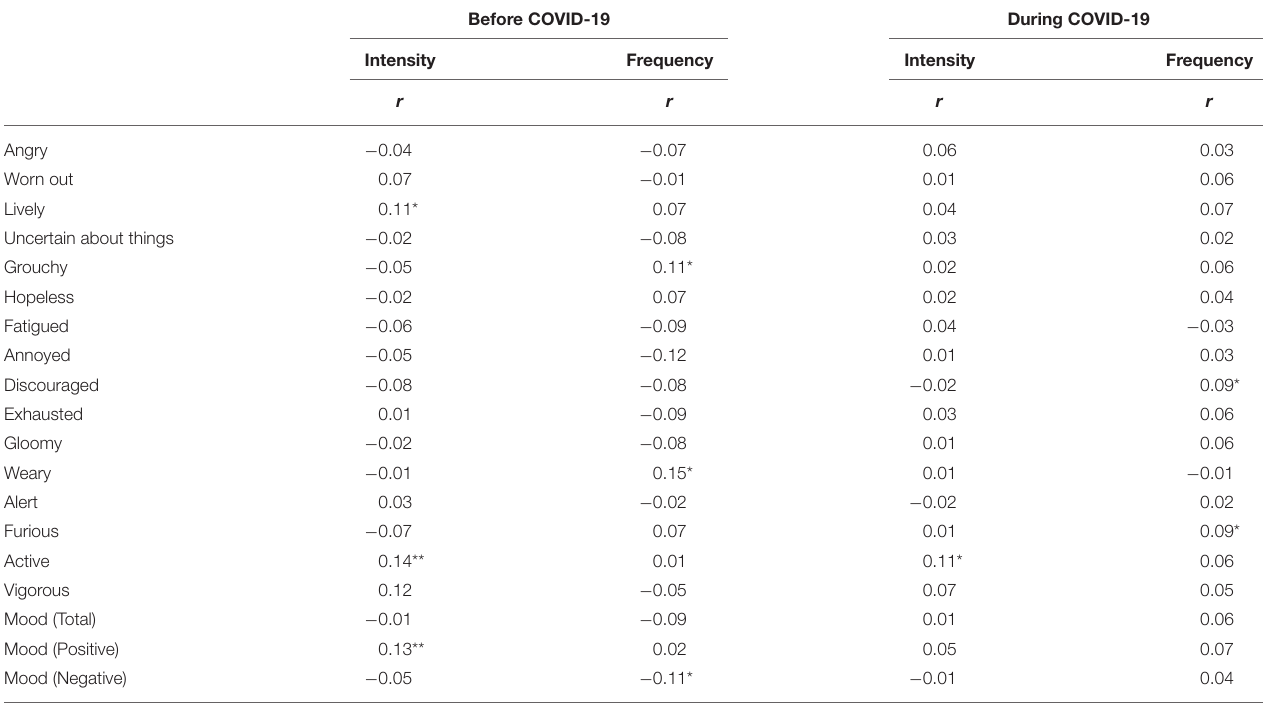
TABLE 6 | Correlation coefficients between PA indices and mood states